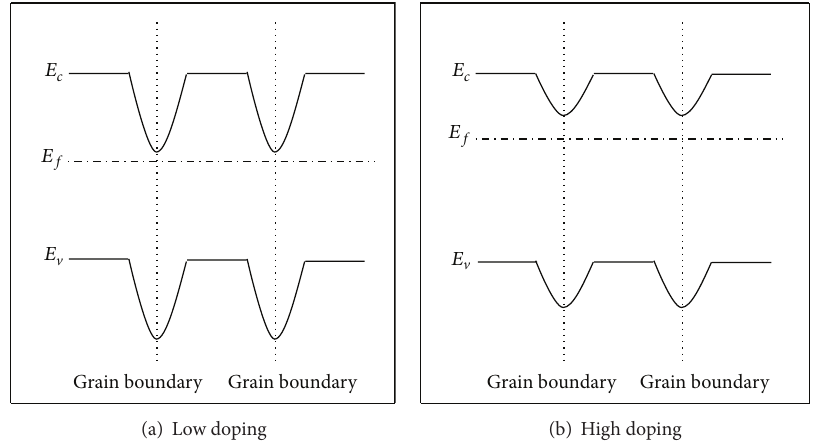
Figure 3: Illustration of the energy band of (a) low doping and (b) high doping